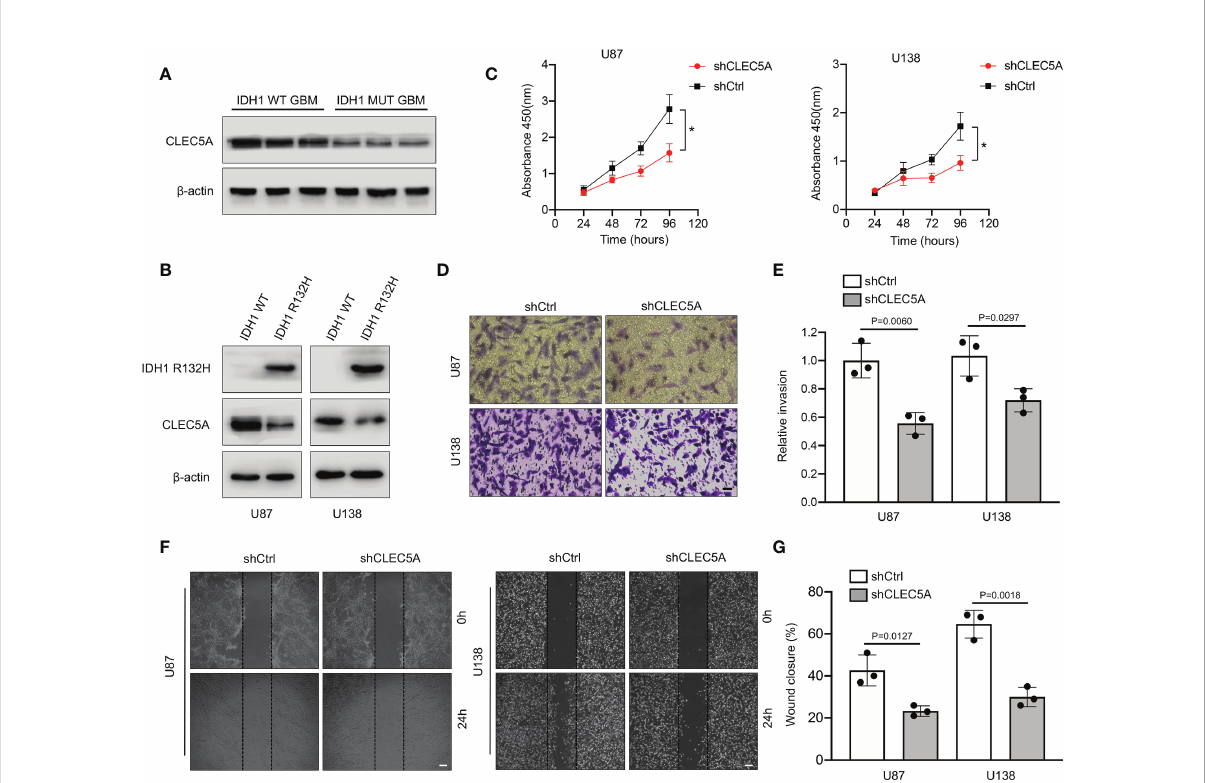
FIGURE 12 Evaluation of expression level and the function of CLEC5A in vitro . (A) Detection of the expression level of CLEC5A in IDH1 WT and MUT human GBM tissues by Western blotting. (B) Western blotting showing CLEC5A and IDH1 R132H protein levels in U87 and U138 GBM cells transduced with IDH1 R132H or vector control. (C) Percentage of viable U87 and U138 cells transfected with shCtrl or shCLEC5A. *p < 0.05. (D, E) Representative images of transwell invasion assays using U87 and U138 cells transfected with shCtrl or shCLEC5A. Quanti fi cation of transwell invasion assays is shown, scale bar = 100 m m. (F, G) Wound healing assays using U87 and U138 cells transfected with shCtrl or shCLEC5A. Wound coverage was detected and photographed after 24h. Quanti fi cation of wound healing assays is shown, scale bar = 200 m